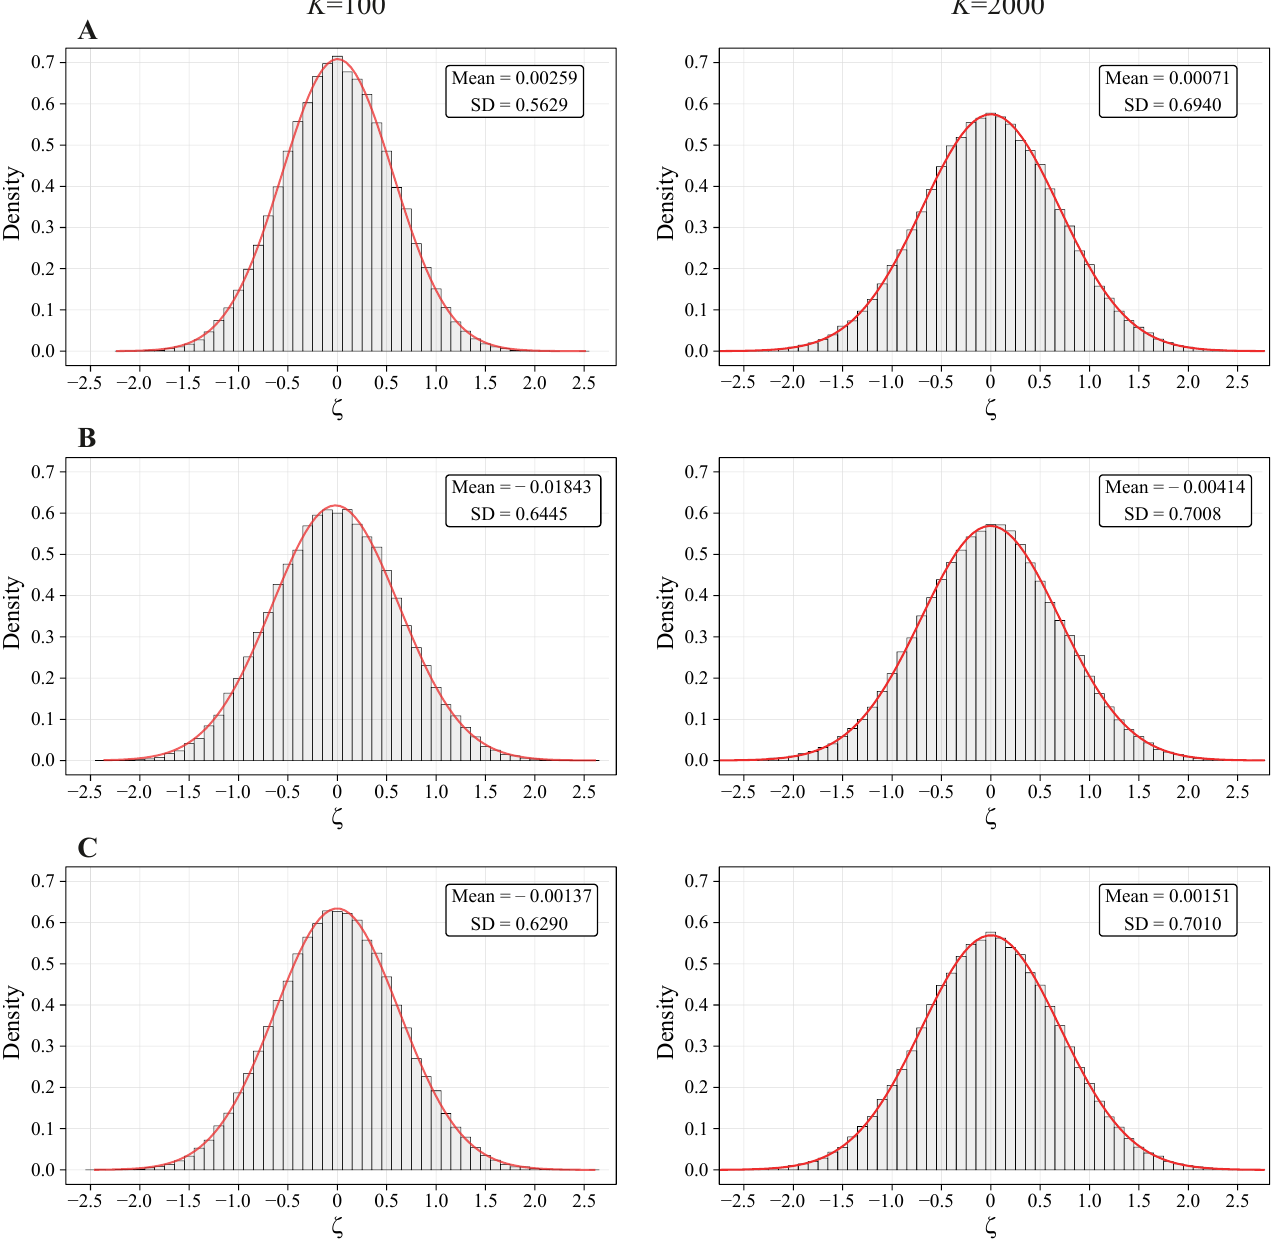
Figure 3. The histograms for the distributions of ζ parameters at different numbers of the nearest neighbors K . The histograms were obtained by 10 5 random realizations. The best Gaussian approxi- mations of observable distributions are shown by solid lines. The corresponding fitting parameters for Gaussian distributions are presented in the inserts. The distributions of ζ parameters for the indices of: ( A ) overlapping (Equations (1), (7) and (15)); ( B ) asymmetry (Equations (2) and (15)); ( C ) coverage (Equations (3) and